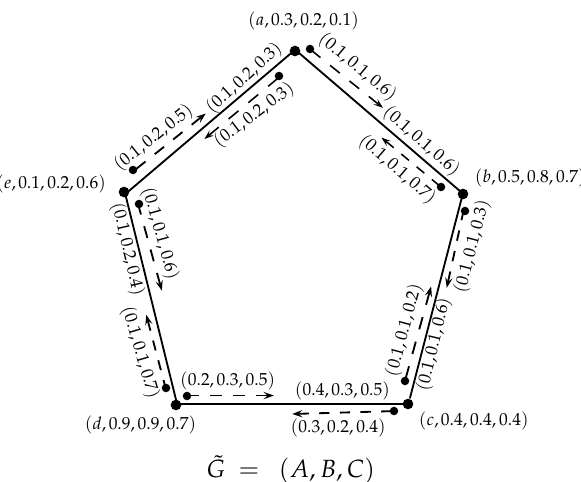
Figure 5. Single-valued neutrosophic incidence